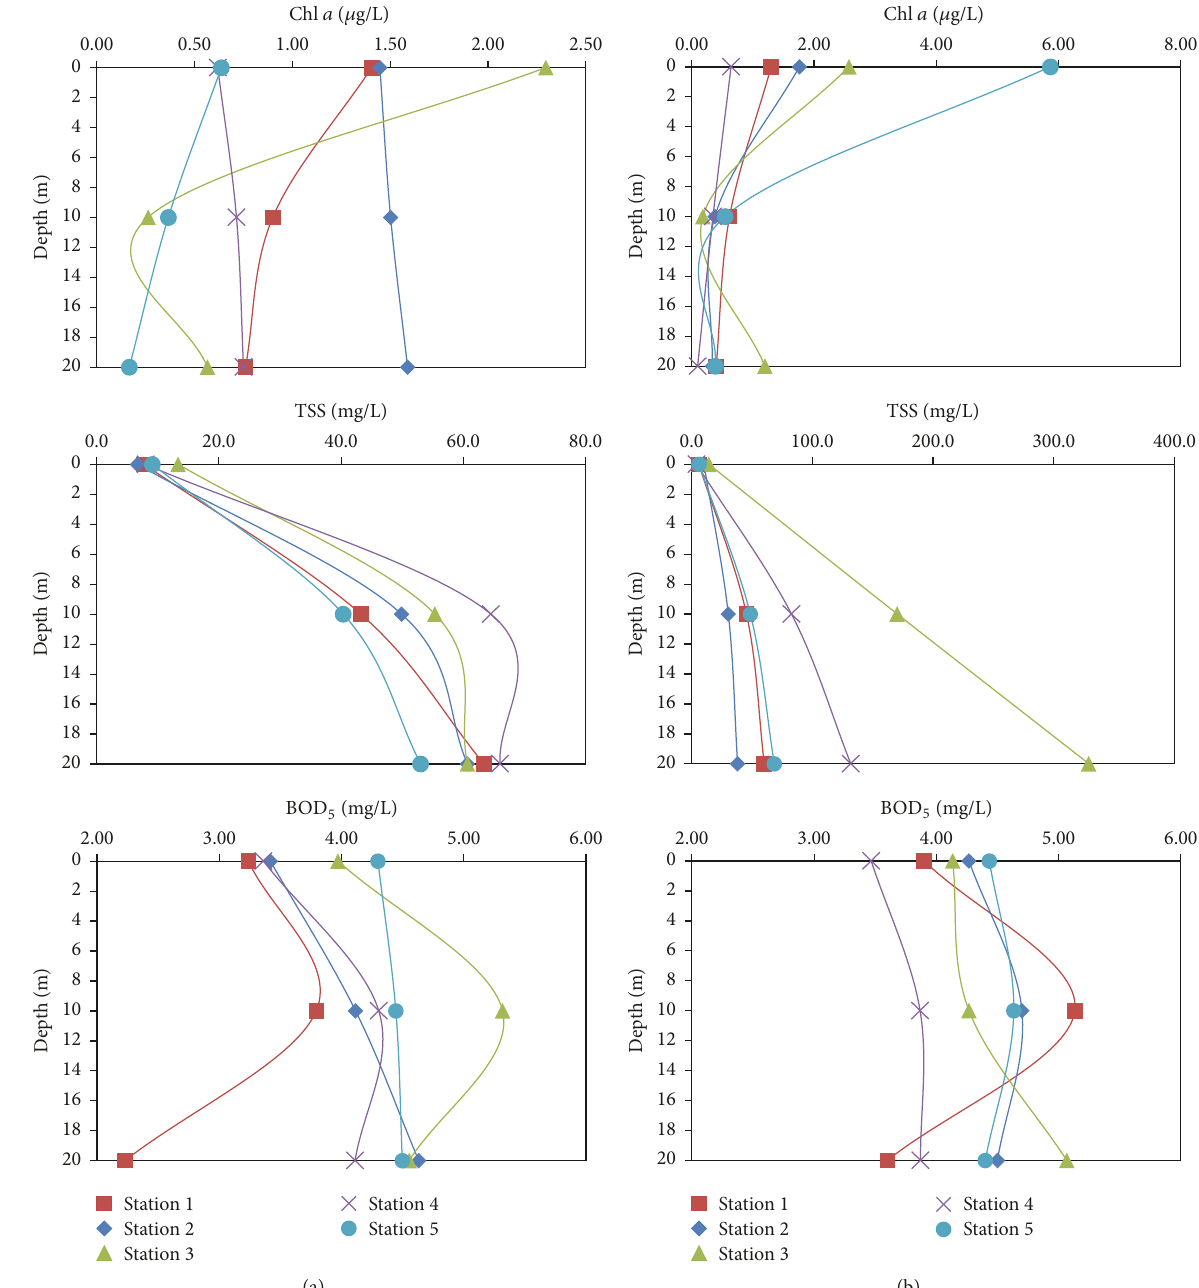
Figure 4: The distribution of Chl a , TSS, and BOD 5 at three different depths (0, 10, and 20 m) of Bakun Reservoir in February (a) and September (b)